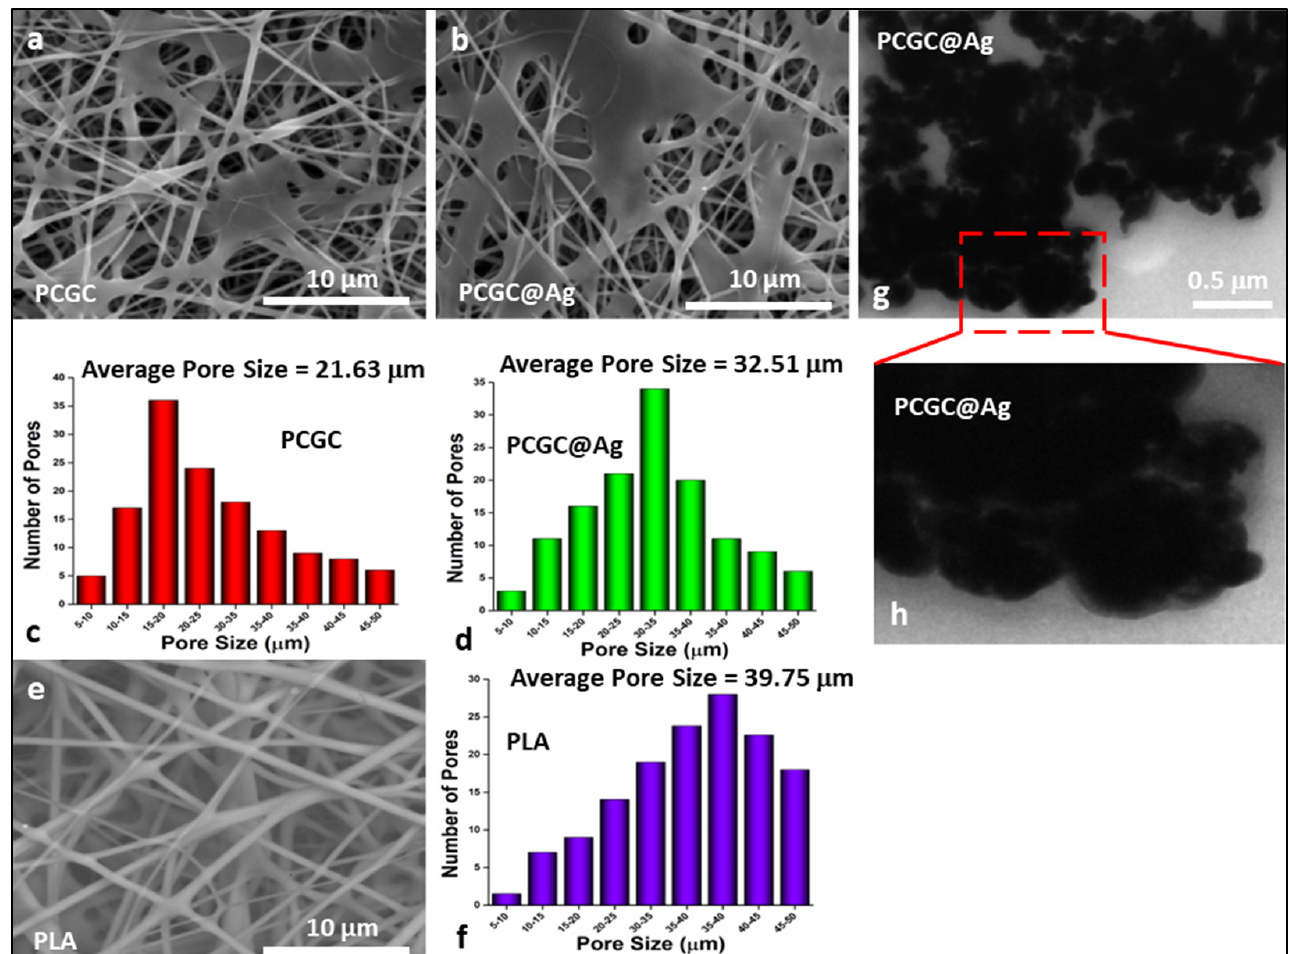
Figure 2. Morphological analysis of the fabricated nanofibrous membranes produced via electrospinning and silver nanoparticles. The SEM morphologies of nanofibers by ( a ) = PCGC, ( b ) = PCGC@Ag, and ( e ) = PLA and their corresponding pore sizes (( c ) = PCGC, ( d ) = PCGC@Ag, and ( f ) = PLA). The TEM morphologies of the silver nanoparticles on the ( g , h ) PCGC@Ag composite nanofibrous membrane samples fabricated using the electrospinning technique, as well as their pore size, were determined by SEM analysis.